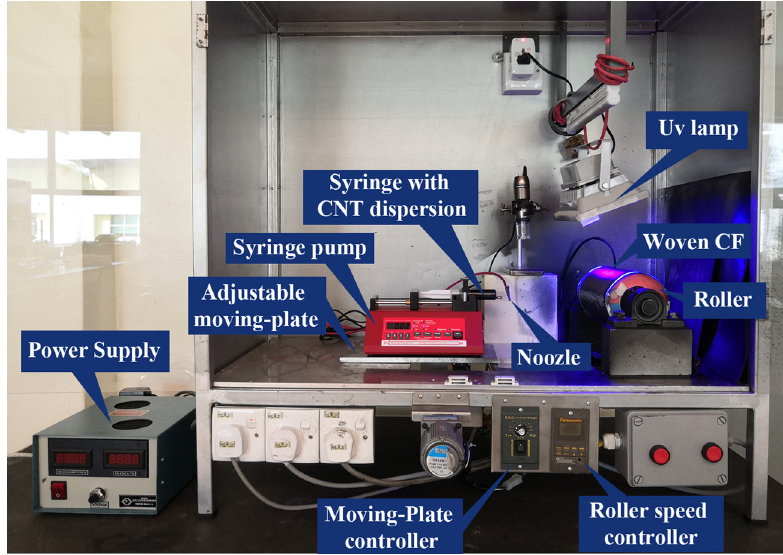
Figure 1: General view of the electrospray deposition